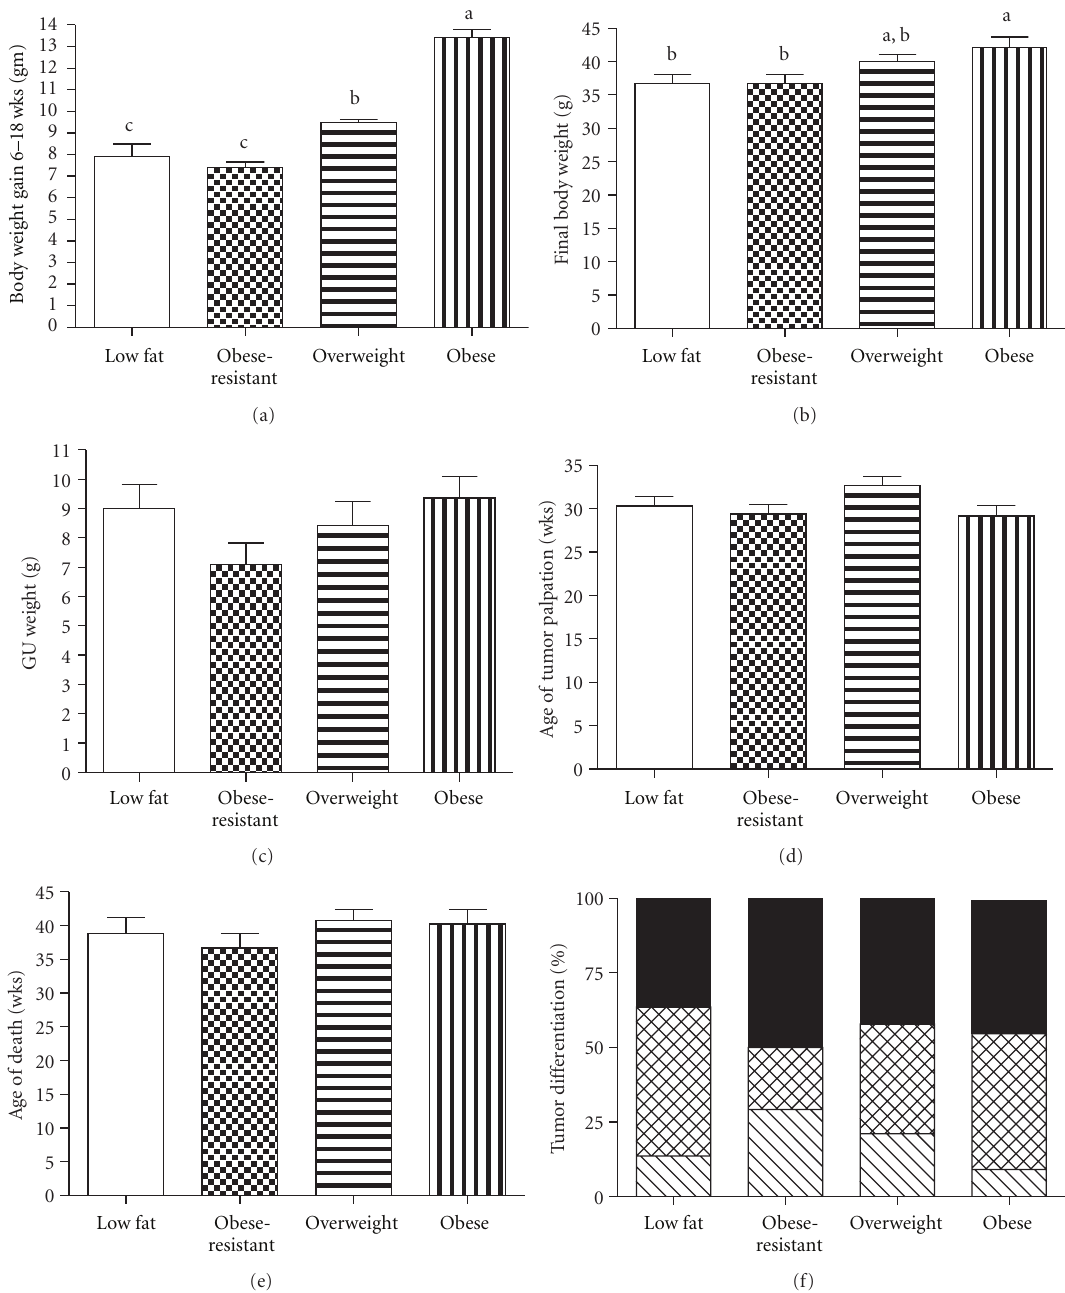
Figure 4: Autochthonous tumor growth in mice with diet-induced obesity. Mice were fed a low-fat diet (open bars) or a high-fat diet and divided into three groups designated as obesity-resistant (checkered bars), the lightest third ( N = 24). Overweight (horizontal bars), the middle third ( N = 24) and obese (vertical bars) the heaviest third ( N = 24). (a) Weight gain from 6–18 weeks (overall ANOVA P < 0 . 0001) with weight in grams shown along the y -axis. (b) Final body weight with grams along the y -axis (overall ANOVA P = 0 . 0158). (c) GUT weight with grams along the y -axis (overall ANOVA P < 0 . 1723). (d) Age of tumor palpation with weeks along the y -axis (overall ANOVA P < 0 . 1235). (e) Age at death with weeks along the y -axis (overall ANOVA P < 5196) and (f) GUT pathology with PIN/well di ff erentiated (angled lines in bar), moderately di ff erentiated (hatched lines in bar), and poorly di ff erentiated (filled part of bar). Each bar represents one group with the percent of di ff erent tumor grades shown along the y -axis. Error bars are standard error and letters show significance di ff